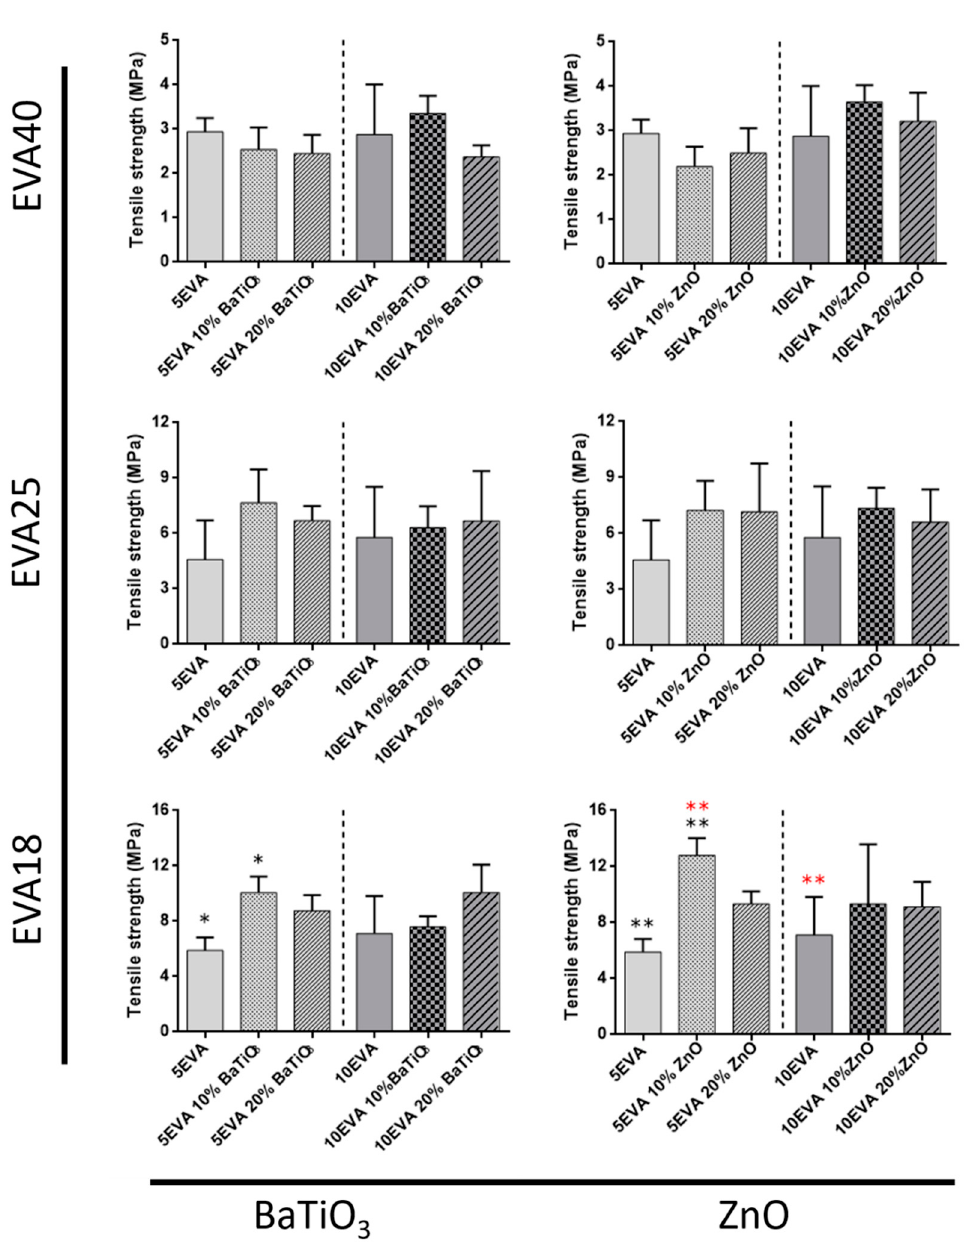
Figure 5. Tensile strength of nanocomposite EVA-based matrices subdivided for the content of vinyl acetate and the ceramic nanomaterial included. * = p < 0.05, ** = p < 0.01. Di ff erent colors have been used to evidence the statistical significance between the compared cases in each graph.